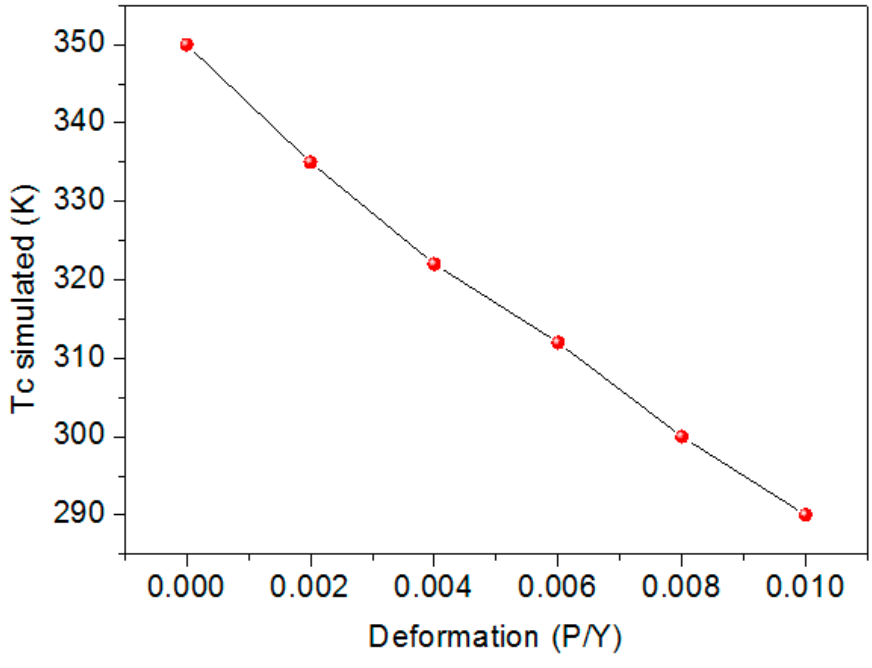
Figure 10. Simulated critical temperature behavior of an LSMO film of thickness d = 9 with respect to deformation in the z deformation in the z direction.